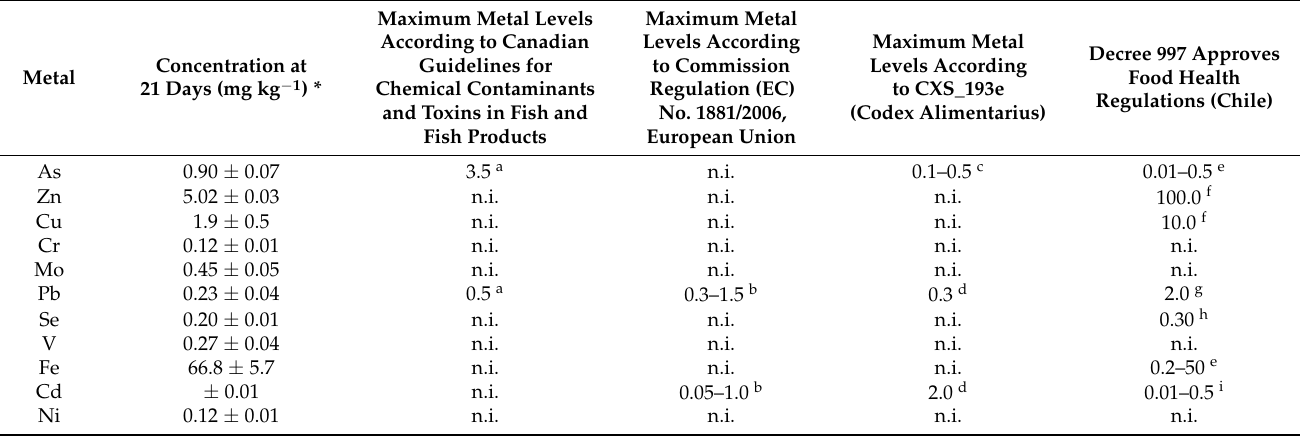
a In fish protein concentrate. b In muscle meat of fish and/or bivalve mollusks. c In all categories shown except for natural mineral water. d In marine bivalve mollusks. e Minimum and maximum values of all products shown seafood. h In solid products. i Edible table salt mineral water. n.i. indicates the absence of regulatory limits for that metal. * Average ± SD fresh